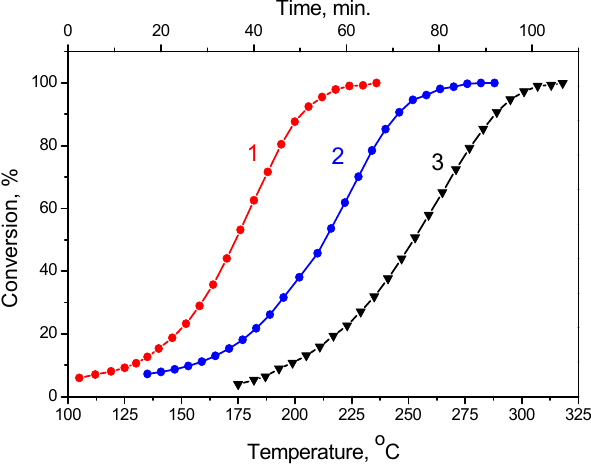
Figure 10. Dependence of the FA conversion on temperature over catalysts prepared using Pt(NO 3 ) 4 as the precursor: 1% Pt/N-graphene (Pt(NO 3 ) 4 ) (1); 0.2% Pt/N-graphene (Pt(NO 3 ) 4 ) (2); N-graphene (3). Table 3. Temperature of 50% FA conversion over the studied catalysts and the support.